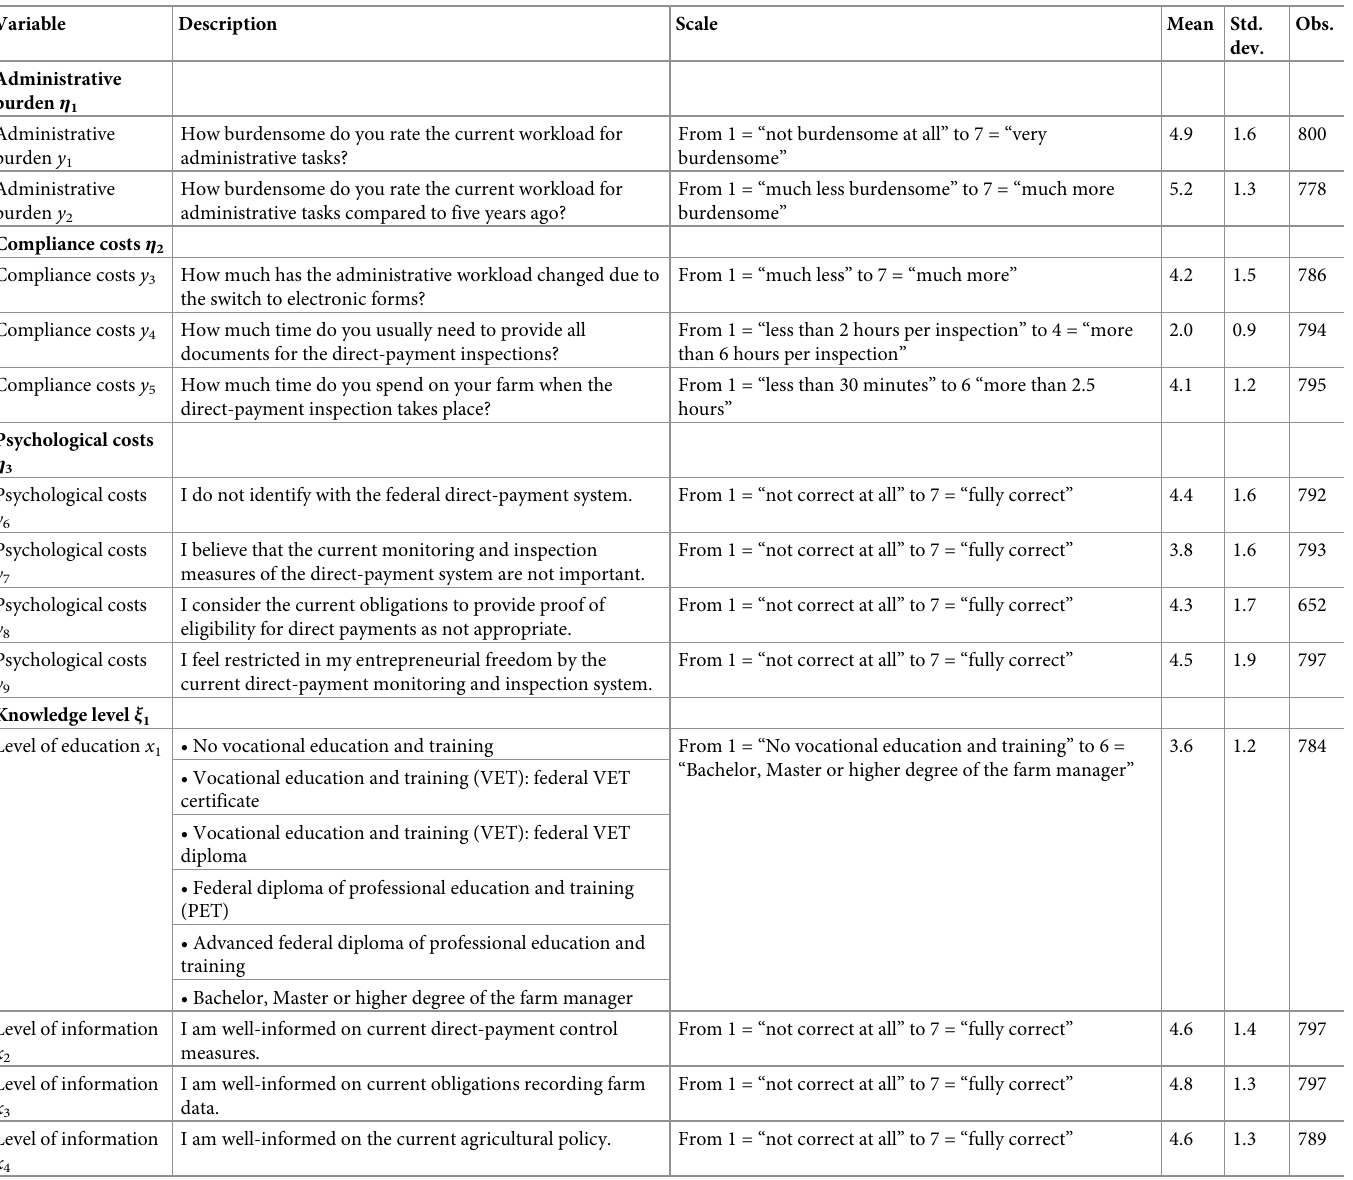
Table 2. Description and summary statistics of data used for the empirical